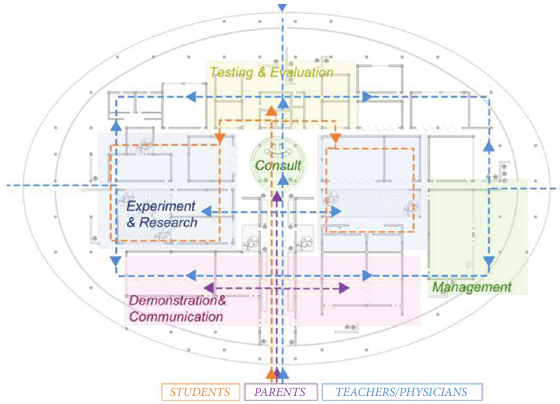
Figure 15: Using of